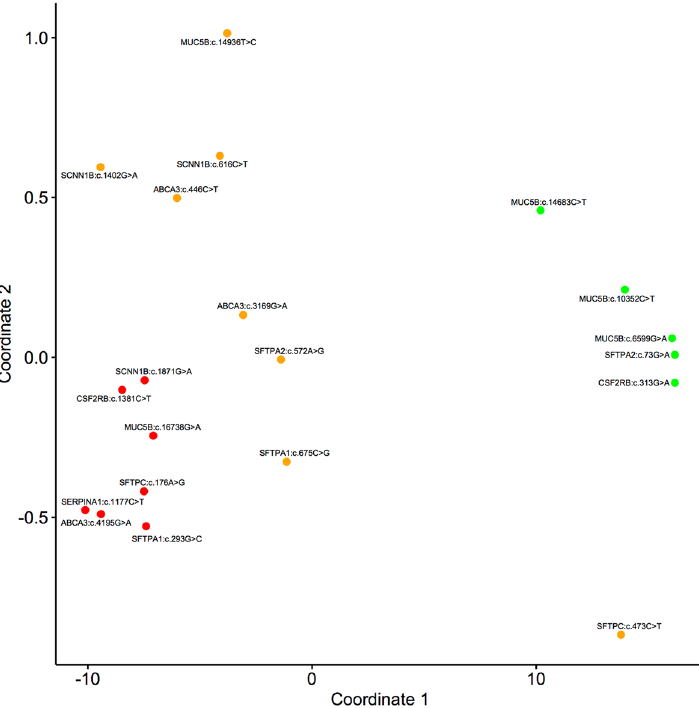
Figure 1. A multidimensional scaling (MDS) plot for the 20 missense variants, using all scores shown in Table 1. The three k-means clusters obtained are colored in red (likely pathogenic), orange (uncertain), and green (likely